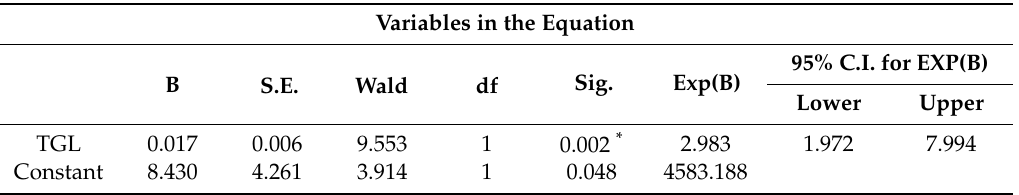
Table 6. Logistic Regression (by Forward Stepwise (Wald) method) using MTHFR A1298C as a dependent variable.